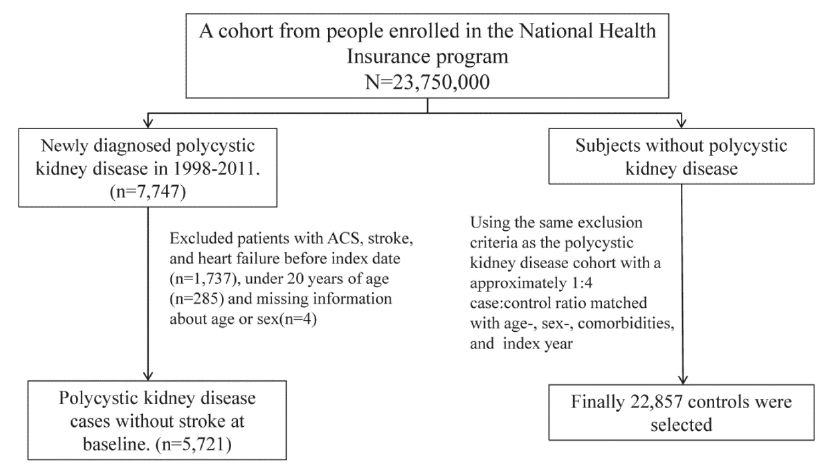
Figure 1. Shows the selection process of the participants in the 2 study cohorts.